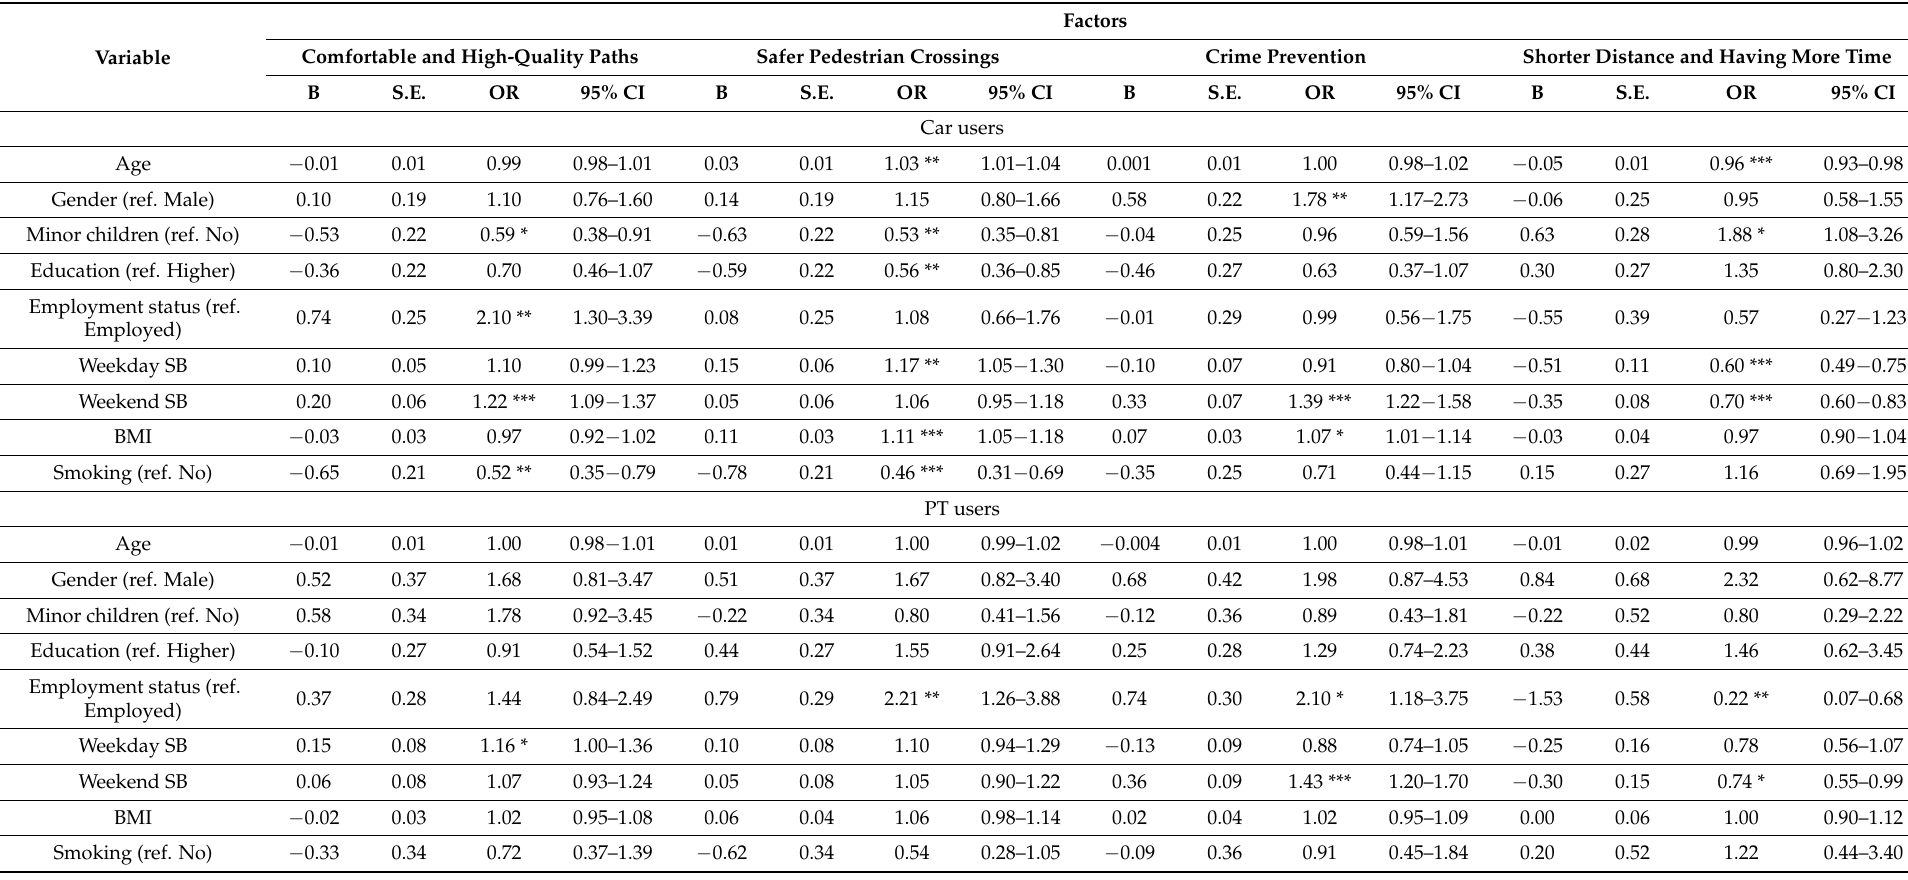
Table 4. Associations between individual characteristics of the study participants and factors encouraging walking among car and PT